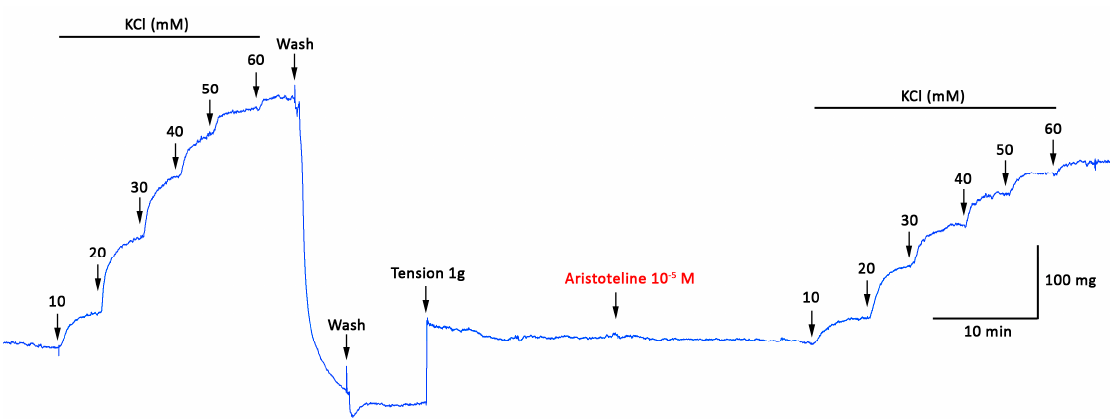
Figure 3. Original trace showing the time course of the concentration–response curves to KCl in intact aortic ring from rat in absence and presence of ARI (10 − 5 M). The aortic ring was pre-incubated with ARI for 20 min before KCl was added.